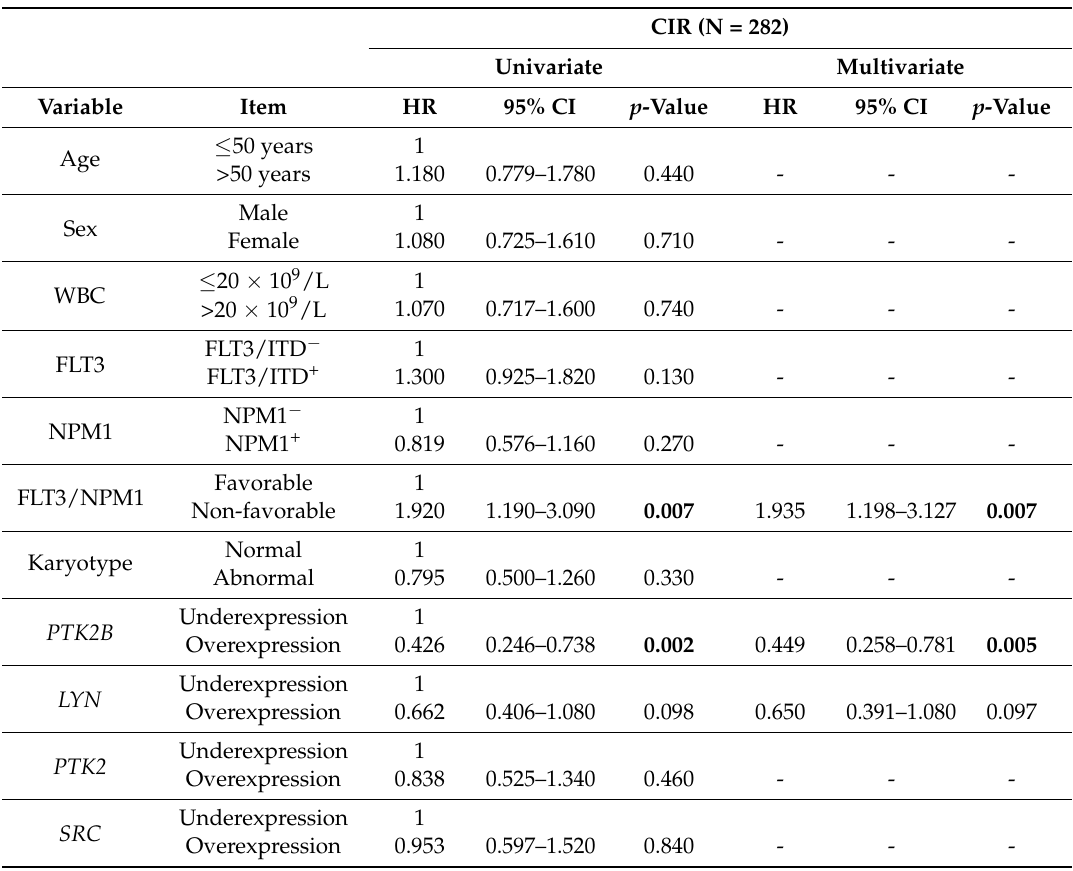
Table 2. Univariate and multivariate analyses of the association between relevant clinical variables and focal adhesion gene expression with cumulative incidence of relapse (CIR) in the cytogenetic IR-AML